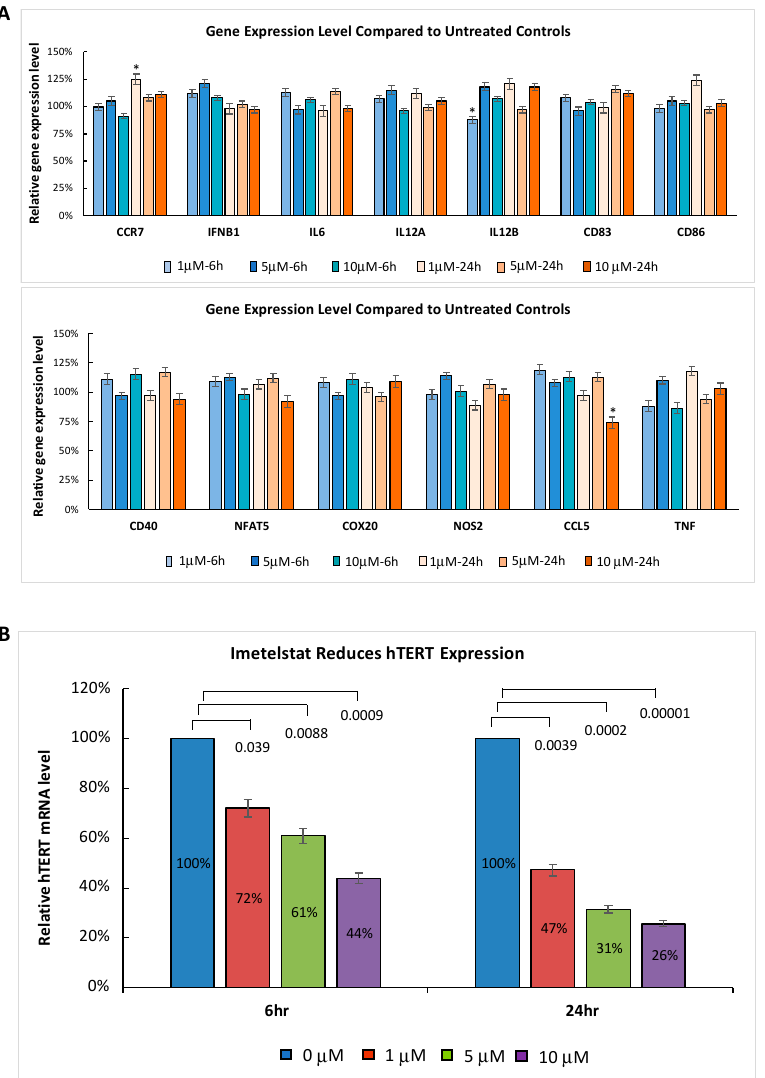
Figure 2. MPN HEL cells were treated with 0, 1 µM, 5 µM, or 10 µM imetelstat for 6 and 24 h in triplicate. RNA was isolated and gene expression profiling was performed using the Affymetrix GeneChip. The mean percentage of gene expression induced by imetelstat treatment at different concentrations was compared to the corresponding untreated control at given time points. Error bars are standard deviations. ( A ) Imetelstat did not significantly induce the expression of the TLR signaling pathway target genes (* p < 0.05). ( B ) Dose-dependent reduction of hTERT RNA expression level by imetelstat treatment. The p -values are indicated. Table 2. Features required for TLR9 activation compared to imetelstat sequence [12]. Requirement Imetelstat